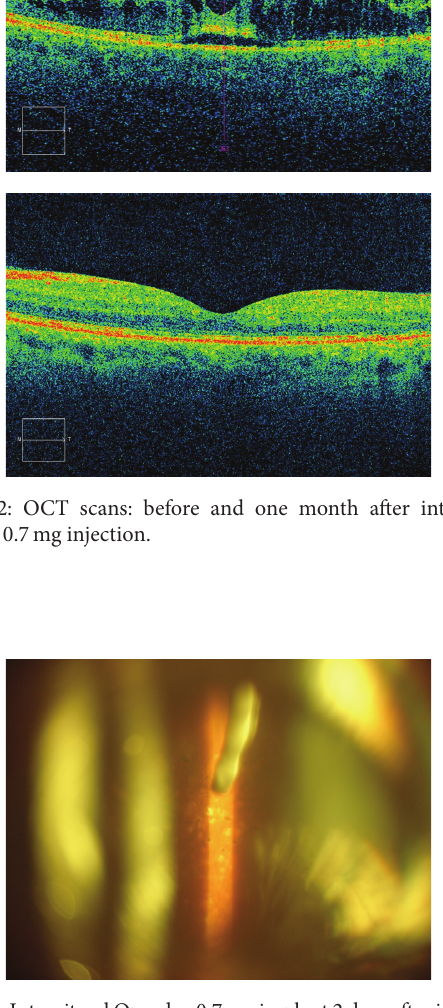
Figure 3: Intravitreal Ozurdex 0.7 mg implant 2 days after